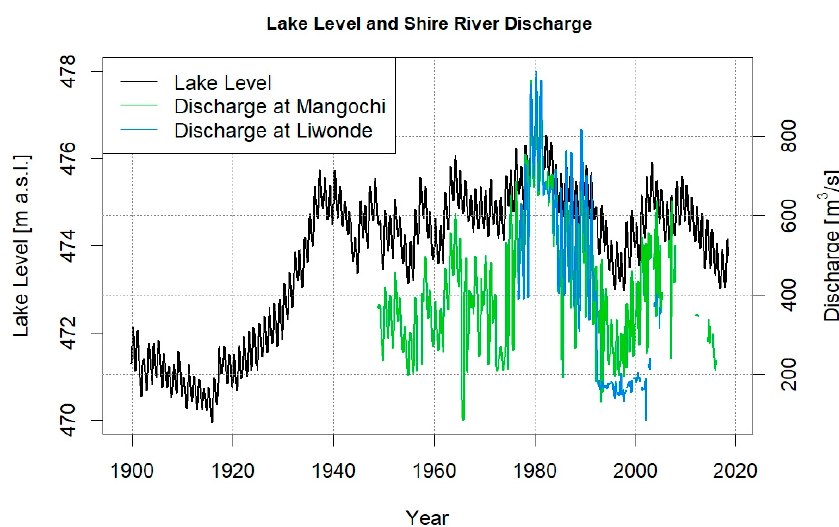
Figure 2. Monthly lake level (from 1899 to 2018), lake outflow at Mangochi (1976 to 2004) and Shire River discharge at Liwonde (1948 to 2008).